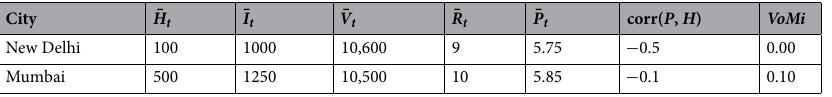
Table 1. Average socio-epidemiological values for the New Delhi and Mumbai. Average weekly values for hospitalization H , cases I , tweet volume, retweet and positivity ( V , R , and P ), as well as Pearson correlation between positivity and hospitalization. Average VoMi also provided. The Pearson correlation is proportional to the first regression coefficient of the ARIMA forecasting model and the geokriging factor of hospitalization predictions. The higher corr ( P , H ) the higher the potential risk aversion for the city (areas and time periods) considered. It is empirically observed that the higher the risk aversion the lower the social (Twitter) generation of information and the healthcare pressure defined by combined case and hospitalization magnitude. VoMi is expected to be higher for less risk-averting city areas (and time periods) with higher incidence (thus misinformation is more predictive of cases and hospitalization) and these areas/time periods should appear more local in terms of circulating